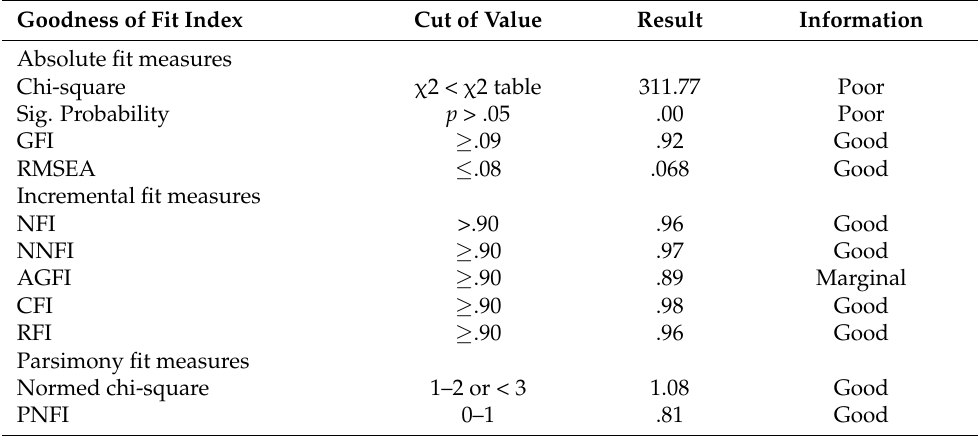
Table 4. Goodness-of-fit statistics.